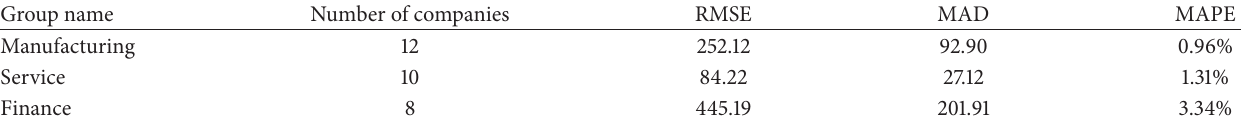
Table 6: The forecasting results of each group by using the proposed sales forecasting model.